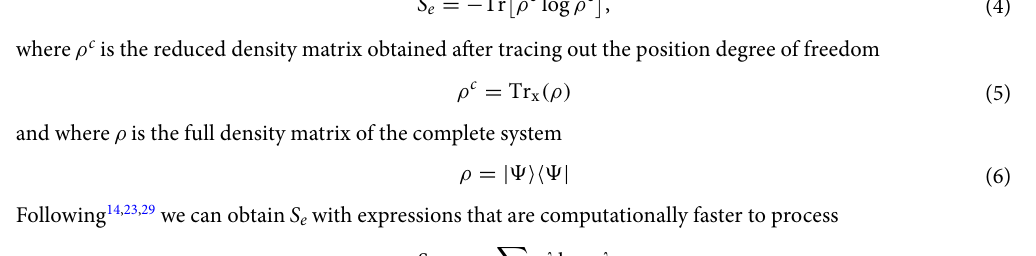
t α employing t max ∼